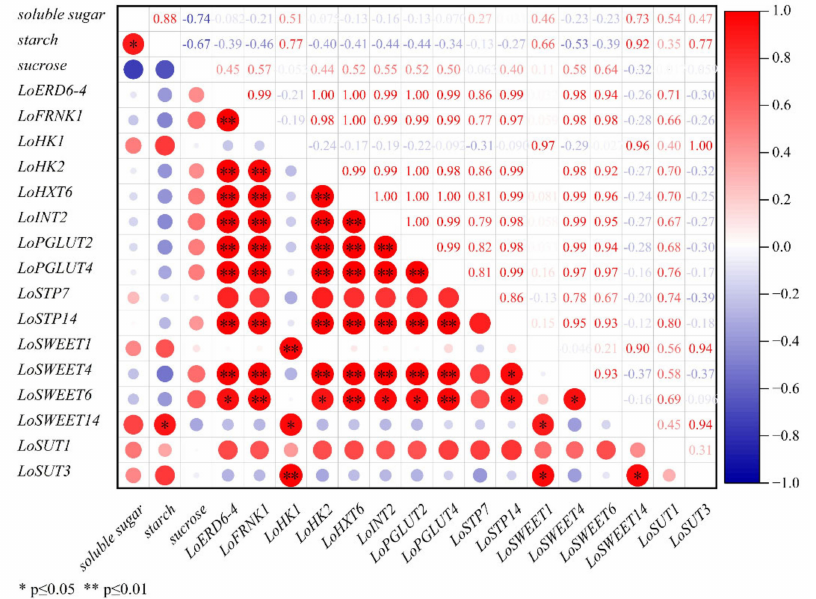
Figure 6. Correlation plot between sugar content and expression levels of ST genes during the assimilates transport in bulbs. The figures in the upper triangular indicates correlation values, which determines the size of the circle in corresponding position in the lower triangular. Blue indicates positive correlations while red indicates negative and the color scale is on the right side. * Significant at 0.05 probability level. ** Highly significant at 0.01 probability